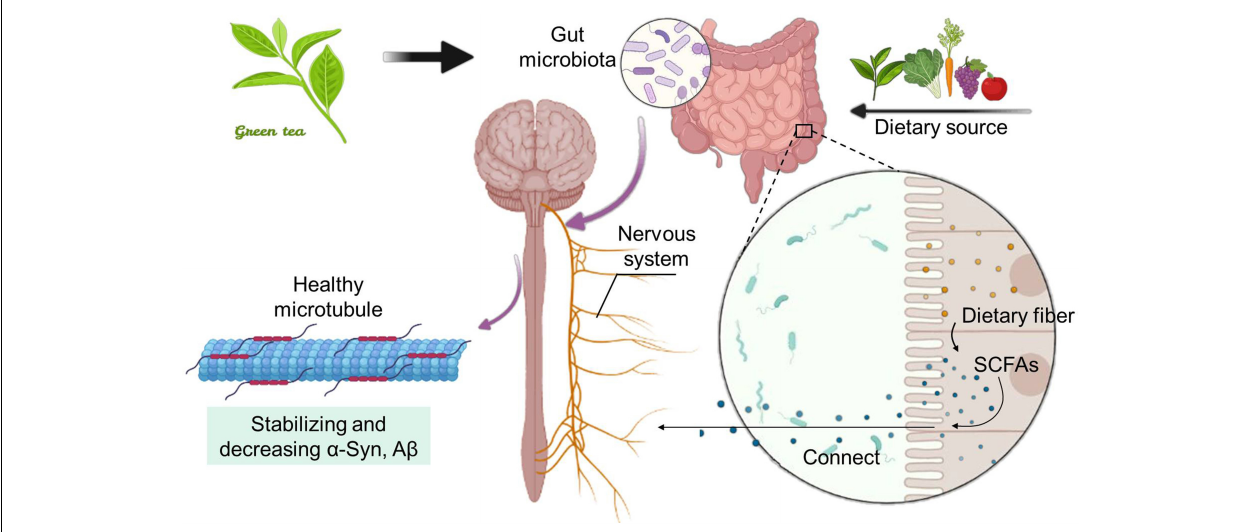
FIGURE 2 | Dietary fiber-produced SCFAs and tea polyphenols-mediated intestinal flora work together to establish a connection with the host nervous system. The intake of TP and dietary fiber can increase the amount of SCFAs, a metabolite in the intestinal tract. The pathway between the intestinal tract and the brain makes SCFAs as a transmission medium, which can effectively improve neurological